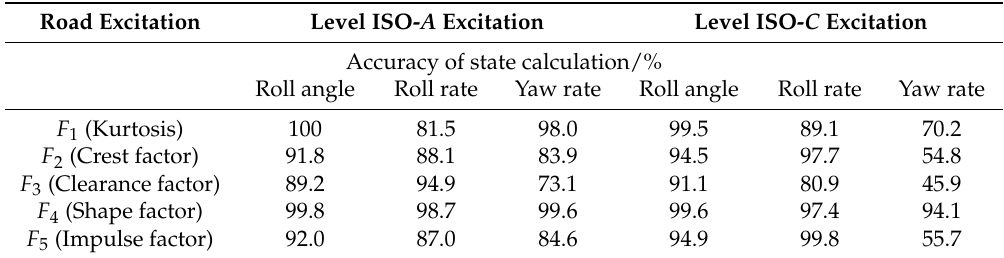
Table 6. Simulation accuracy of comparing 9-DOF model and CARSIM ® with steering wheel 10 ◦